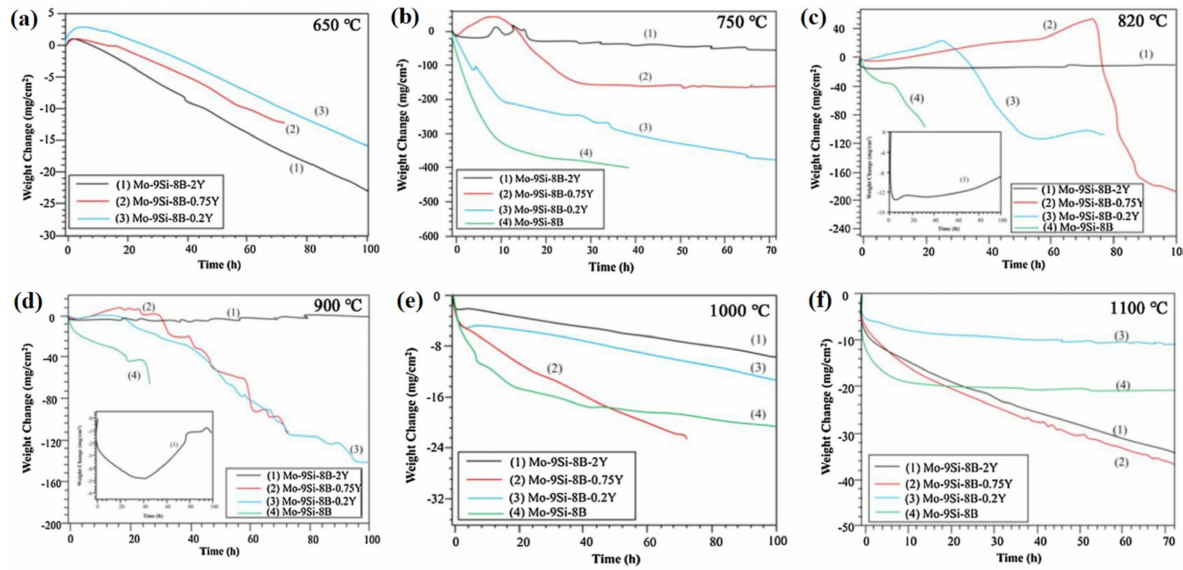
Figure 8. Weight change curves of Y-doped and undoped samples oxidized at ( a ) 650 ◦ C; ( b ) 750 ◦ C; ( c ) 820 ◦ C; ( d ) 900 ◦ C; ( e ) 1000 ◦ C; ( f ) 1100 ◦ C, respectively. Reproduced with permission [122]. Copyright 2014